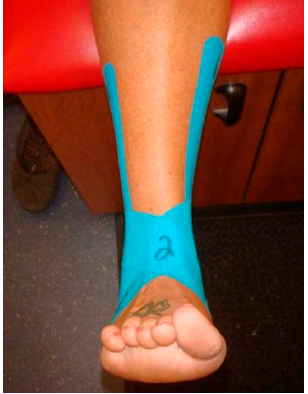
Figure 4. Anterior view of the second strip of Kinesio tape.